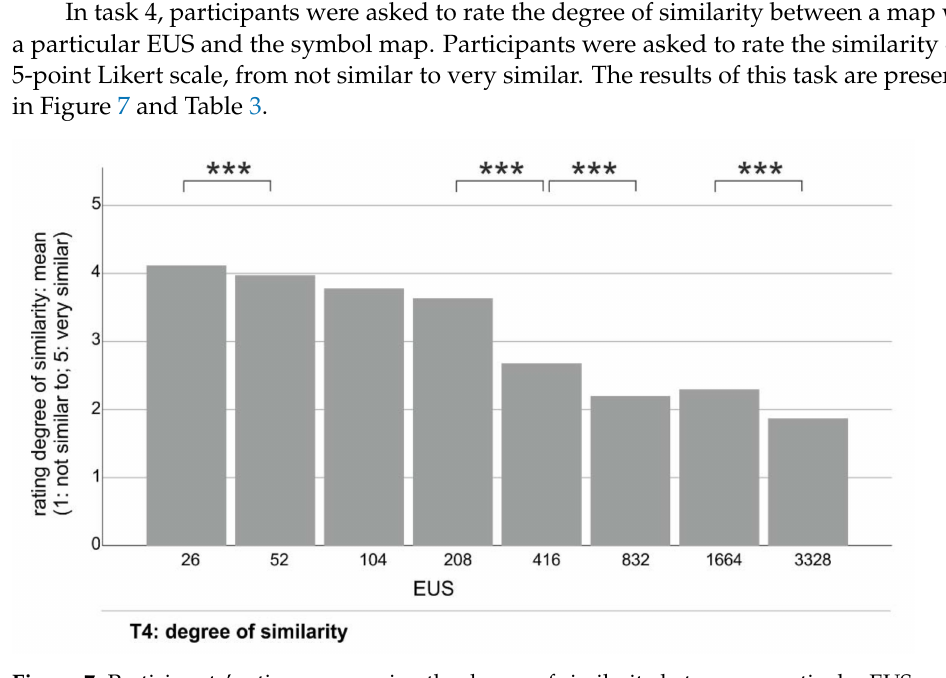
Figure 7. Participants’ ratings concerning the degree of similarity between a particular EUS and the symbol map, *** p ≤ 0.001. Table 3. The pairwise comparison of collected answers for task 4. *** p ≤